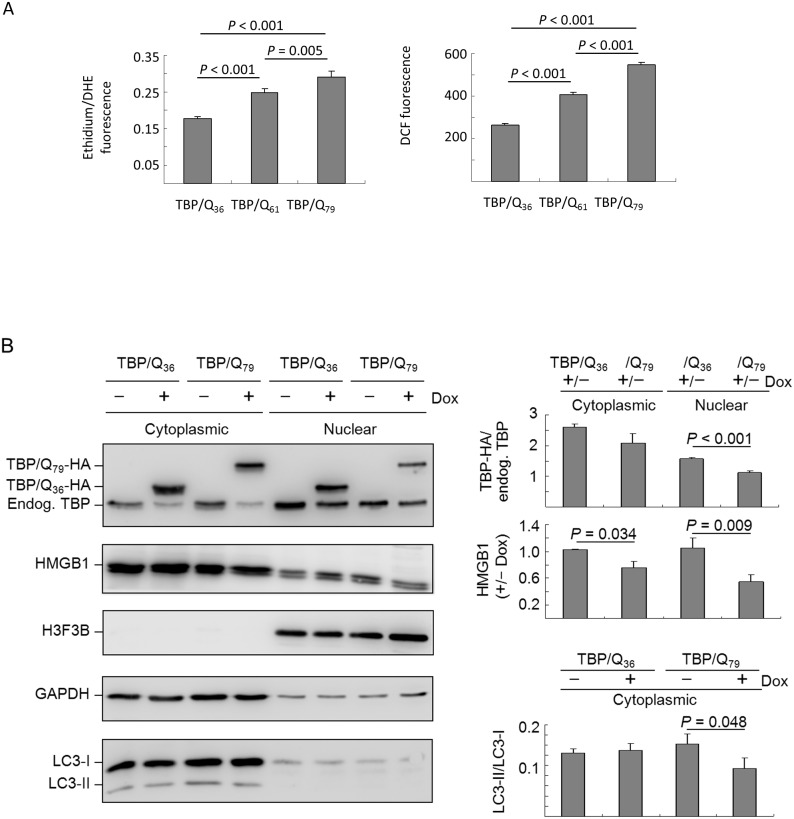
ROS and HMGB1 distribution in starvation-stressed TBP/Q36∼79 293 cells.(A) 293-derived cells were induced for 4 days to express TBP/Q36∼79. The cells were then placed in medium containing 0.5% fetal bovine serum for 2 additional days. The cells were loaded with DHE and DCFH-DA, and superoxide/peroxide production was fluorometrically quantified. The data are expressed as the mean ± SD of three independent experiments. (B) Cells were induced for 6 days to express TBP/Q36 and TBP/Q79, with starvation-stress in the last two days. The extracts were fractionated into the cytoplasmic and nuclear components and analyzed using TBP, HMGB1, H3F3B, GAPDH and LC3 antibodies.